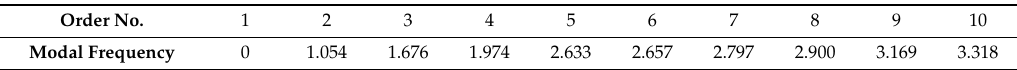
Figure 16. Boundary condition of model. Table 5. Acoustic modal frequency of the cavity of Condition 6.